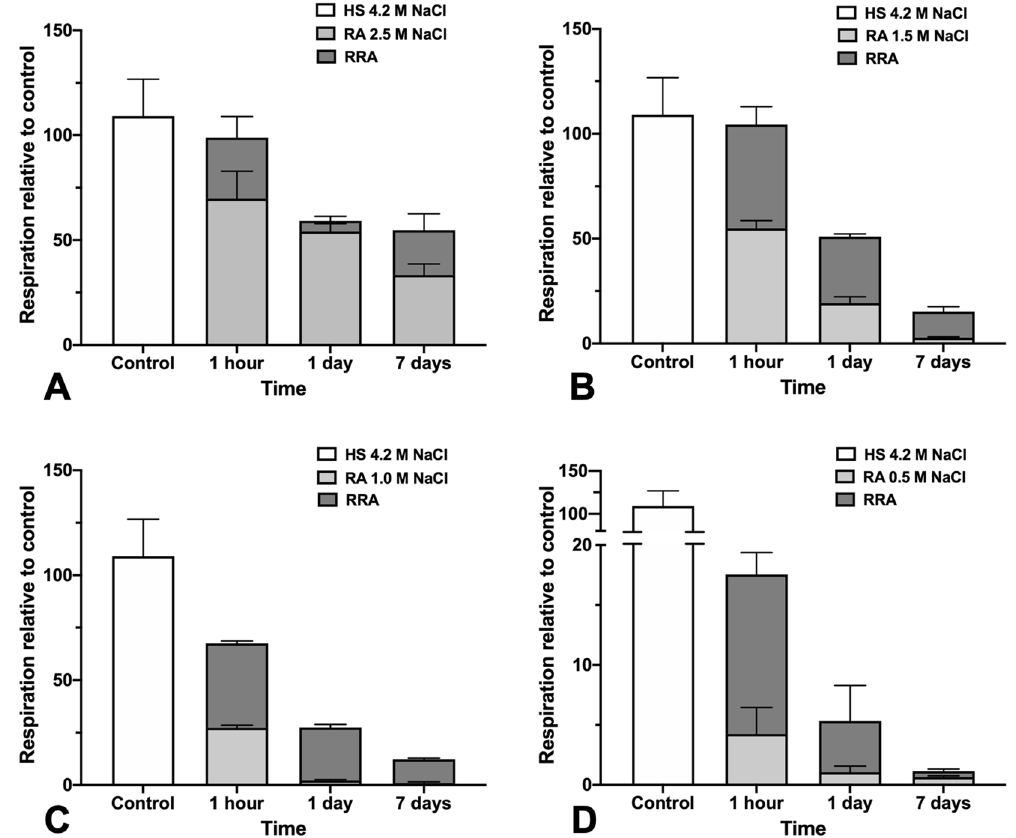
Figure 5. Respiration rate of Hbt. salinarum . Respiration activity (RA, light grey) of cells in low-salt shock (2.5 M, 1.5 M, 1 M and 0.5 M NaCl) measured at 1 hour, 24 hours and 7 days and recovery respiration activity (RRA, dark grey) immediately after transfer of stressed cells in standard 4.2 M NaCl medium. Oxygen consumption of cells was determined at 37 °C using a Unisense oxygen sensor. The experiment starts with basal respiration of unstressed cells (HS 4.2). Harvested cells were then exposed to various low-salt concentrations (( A ) 2.5 M NaCl, ( B ) 1.5 M NaCl, ( C ) 1.0 M NaCl and ( D ) 0.5 M NaCl) during different periods of time for respiration measurement. Finally, oxygen consumption of recovered cells was measured immediately after incubation of stressed cells in 4.2 M NaCl. Basal respiration of unstressed cells was set to 100% in each case. Results are mean values for three independent experiments. Time on the x-axis corresponds to the low-salt incubation time. Note that different scales were used in figure ( D ).